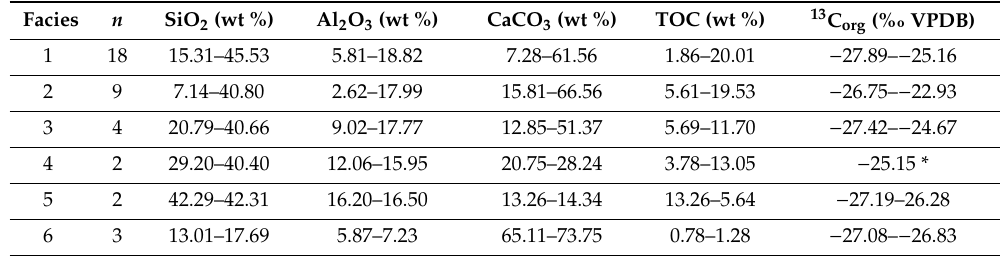
Table 1. Ranges of whole-rock geochemical data for each of the identified facies [14]. * Facies 4 only has one carbon isotope